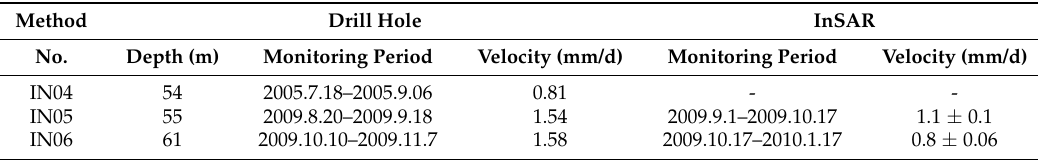
Table 2. The comparison between the inner and surface downslope deformation rate of Section II of Jinpingzi landslide (borehole data are cited from Wang et al. [51] and Xu [59]). Method Drill Hole InSAR